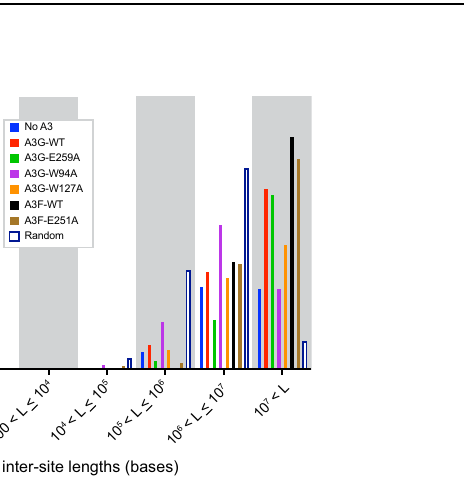
Fig. 4 | A3 residues W94 and W127 play a role in integration site targeting. A Frequencyofintegrationsites withinoratdifferent distanceintervals away from variouscommon genomicfeatures in CEM-SST cellsinfected with HIV-1 generated in the presence of A3G-WT, A3G [W94A], A3G [W127A], or the absence of A3F or A3G( ‘ noA3 ’ control).Theinsetnumbersrefertothepercentageoftotalintegration sitesfallingdirectlywithinthefeature.Thestatisticalcomparisoniswithrespectto A3G-WT. B Heatmaps depicting the fold-enrichment (blue shading) and depletion (red shading) of integration sites at various distance intervals compared to the ‘ no A3 ’ control virus. C Pairwise distance matrix was used to determine the overall similarity between the integration site pro fi les of CEM-SS cells infected with either thenoA3controlvirusorA3F-WT,A3F[E251A],A3G-WT,A3G[E259A],A3G[W94A], or A3G [W127A] virus. The fold-enrichment and depletion values in each distance binofeachcommonDNAfeaturewereusedinthecomparison.Theheatmapshows the distance matrix calculated by Euclidean distance asthe measurement method.